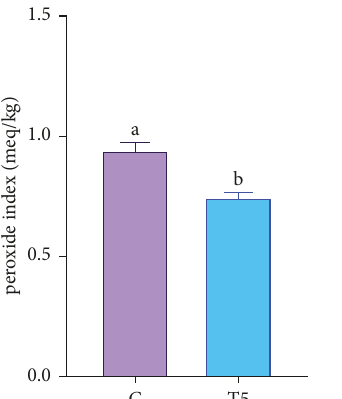
Figure 7: Comparison of Peroxide index of treatment No.5 (Se- lected treatment) with control sample. The data are expressed as mean SD from at least three separate experiments. Inter-group comparisons were made using one way ANOVA. The different lowercase letters indicate the significant difference of peroxide ± index in treatments at p 0 . 05 probability <